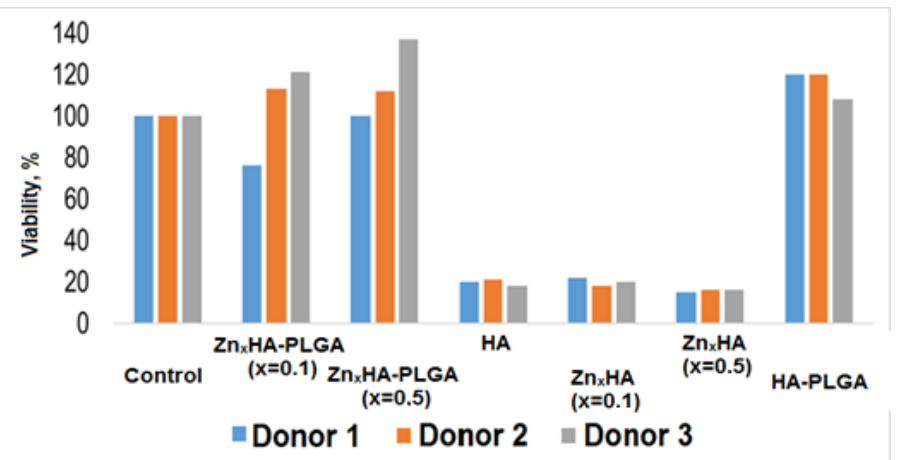
Figure 6 . Viability of human macrophages in the presence of Zn x HA-PLGA composites . Figure 6. Viability of human macrophages in the presence of Zn x HA-PLGA composites. Table 3. Influence of different accessions on the abundance of E. Coli and S. aureus